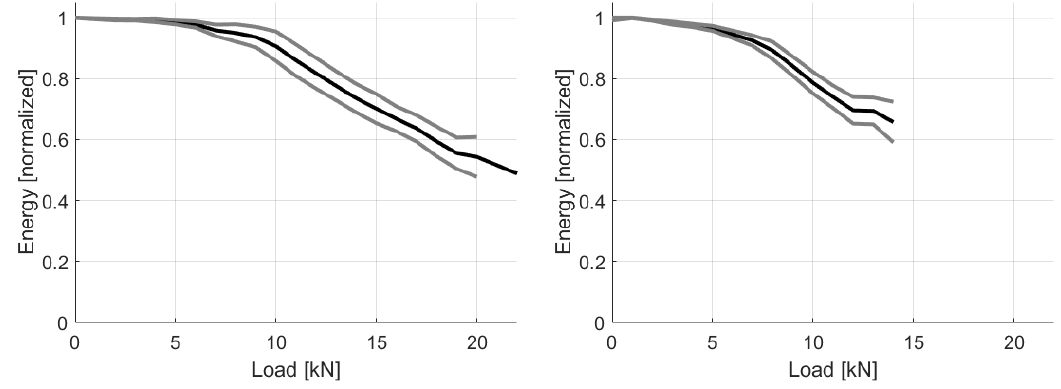
Figure 5. Mean value (black) and standard deviation (gray) of the energy of the evaluated wave package of all test specimens. Left : 0/90 test specimens. Right : +45/ − 45 test